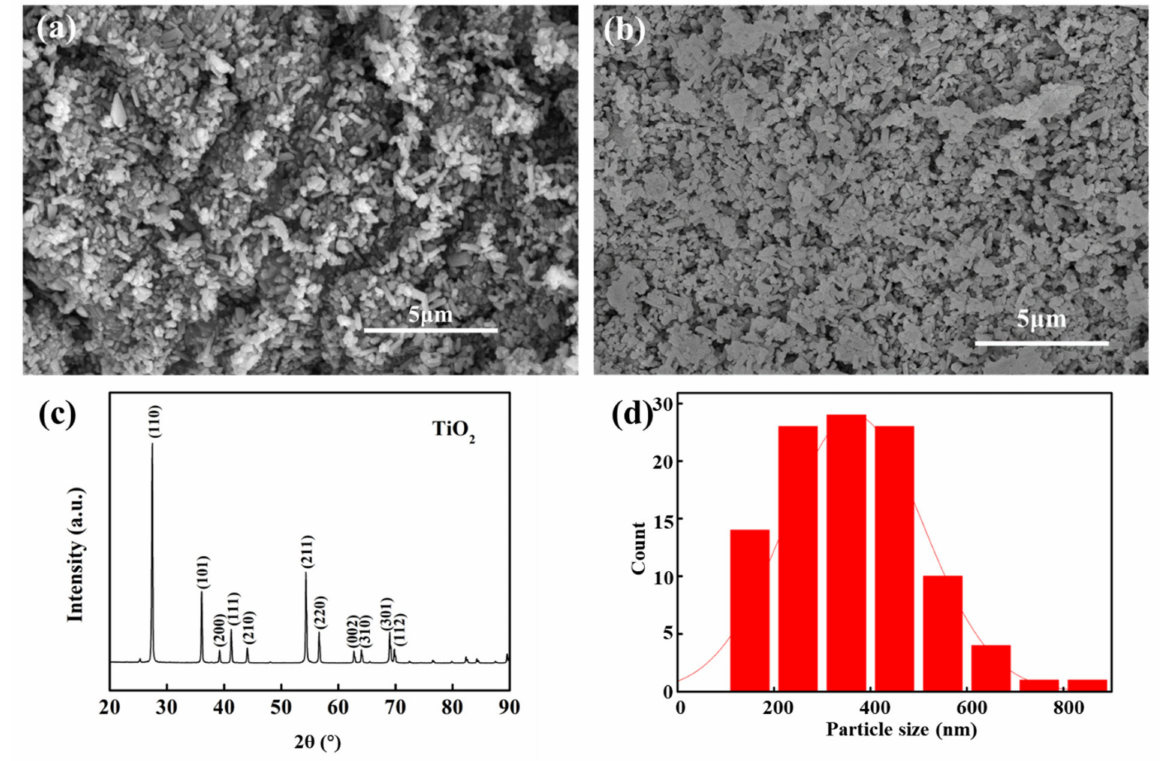
Figure 4. The morphology of the TiO 2 –Al 2 O 3 membrane surface (( a ) without adding PVA, ( b ) with adding PVA), XRD analysis of TiO 2 –Al 2 O 3 membrane surface after the preparation of the intermediate layer ( c ) and particle size statistics of the TiO 2 powder ( d